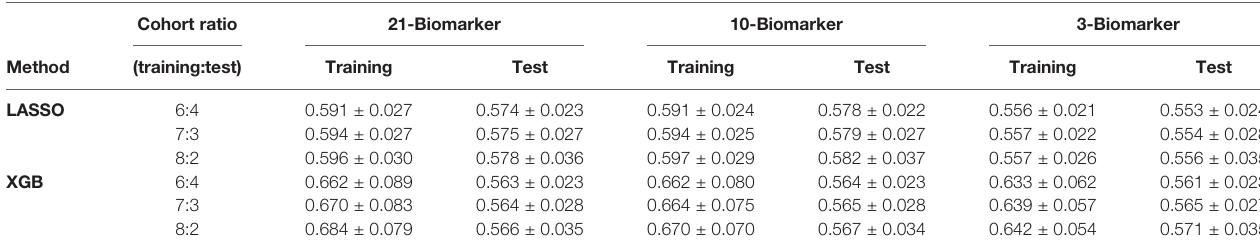
TABLE 1 | Median AUC distribution of the three blood test biomarker panels. Cohort